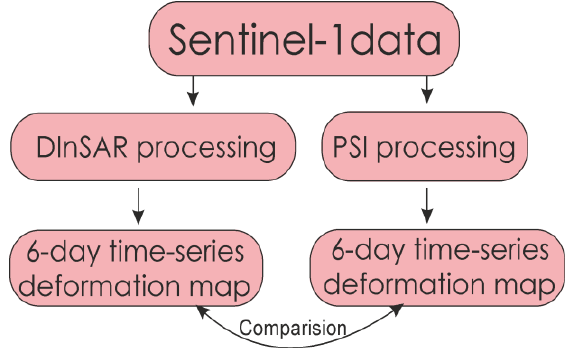
Figure 2. Overall methodology of the presented study